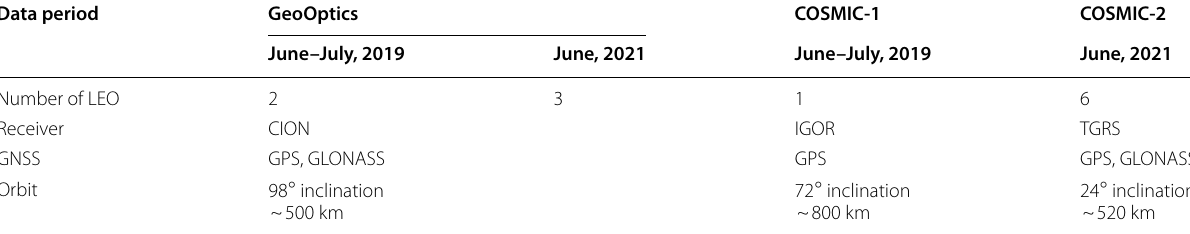
Table 1 Data period and characteristics of each RO mission